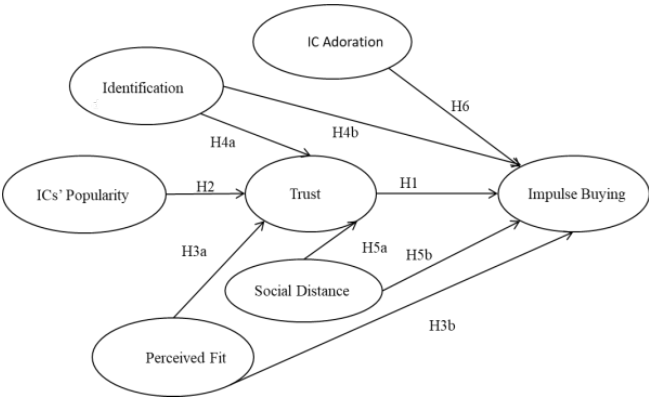
Figure 1. Conceptual model.